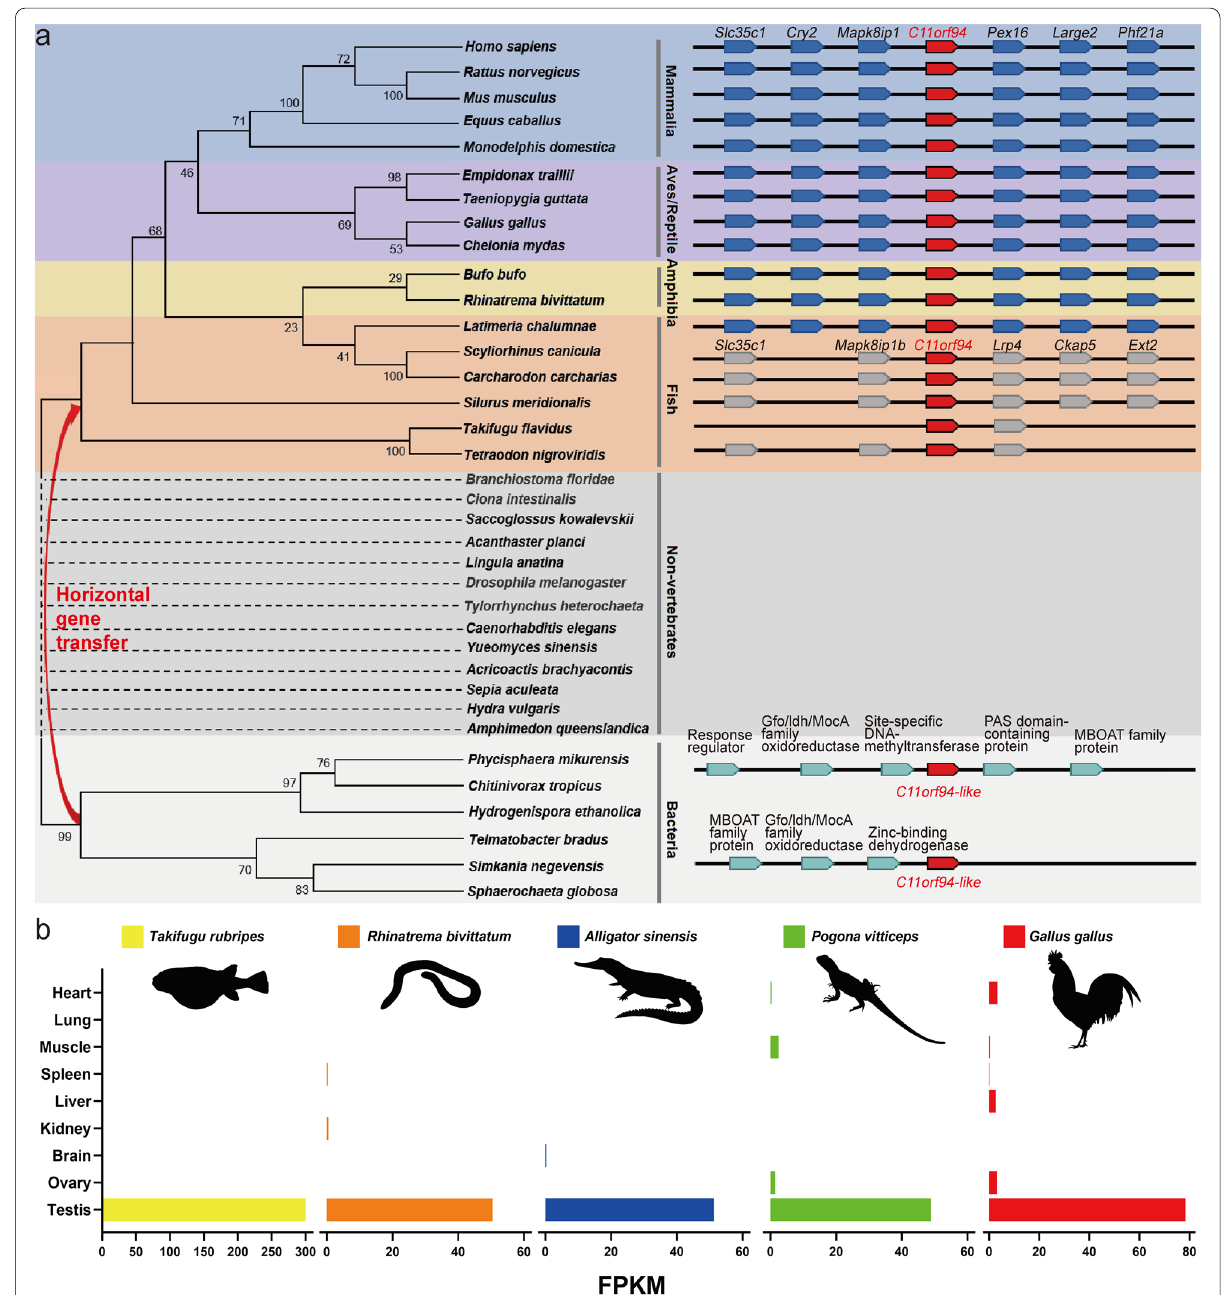
Fig. 2 Conservation analysis of C11orf94 during evolution. A Phylogenetic analysis showed that the C11orf94 gene exist in vertebrates and maybe horizontally transferred from a bacterial genome. Synteny for chromosomal regions containing the C11orf94 gene. The C11orf94 gene and the neighbouring genes in vertebrate genome fragments are shown on right. b RNA-sequencing data acquiring from an existing database indicated that C11orf94 is highly expressed in testicular tissues in vertebrates. Animal profiles were downloaded from PHYLOPIC (http:// phylo pic. org/ image/